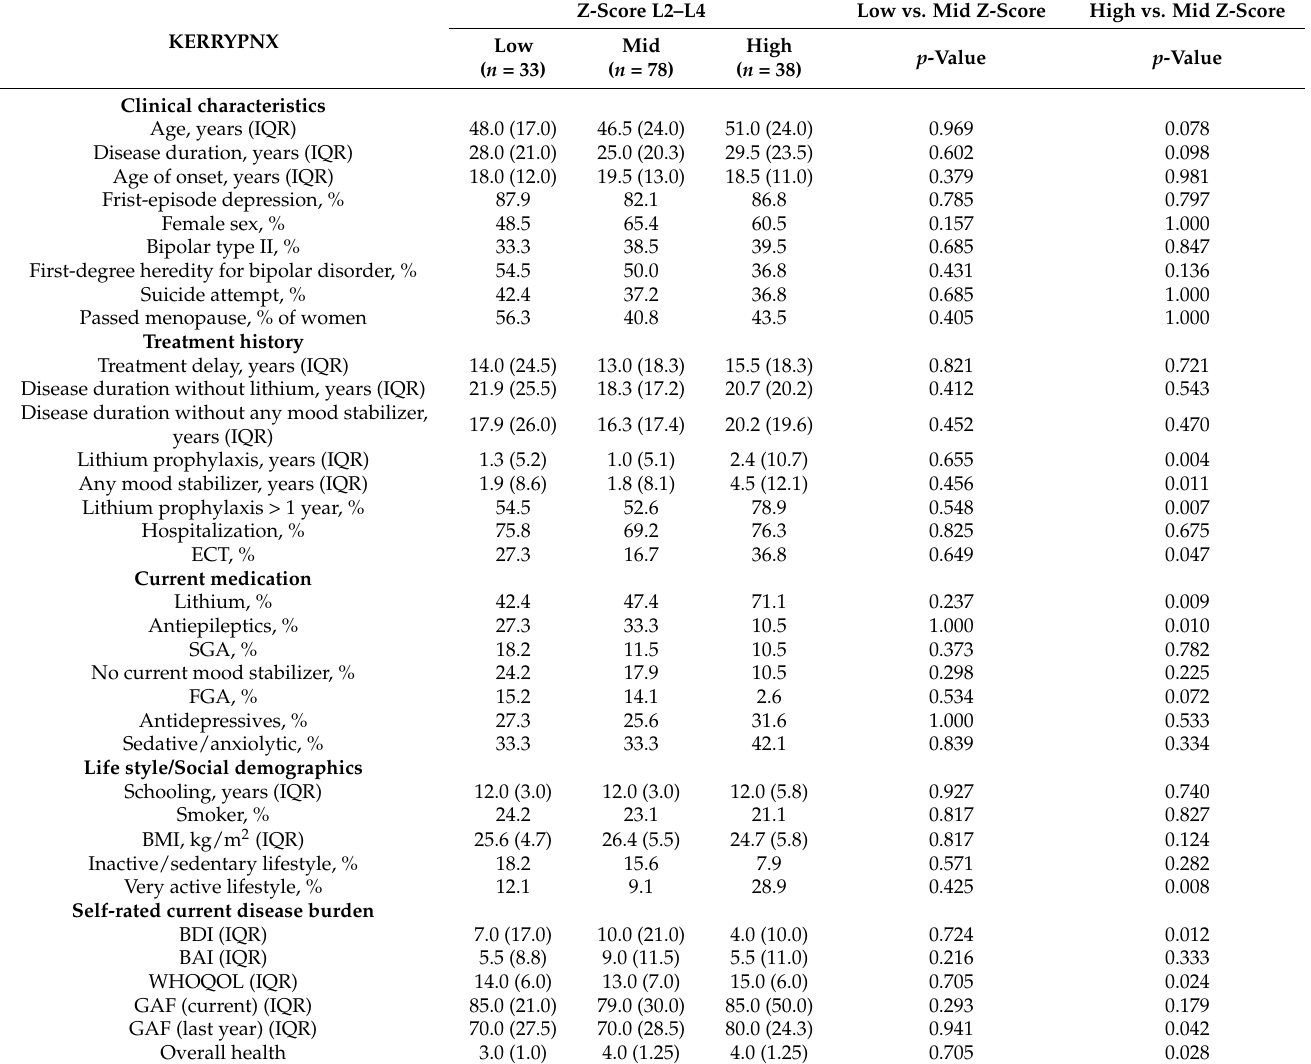
Table 3. Z-score in relation to clinical characteristics